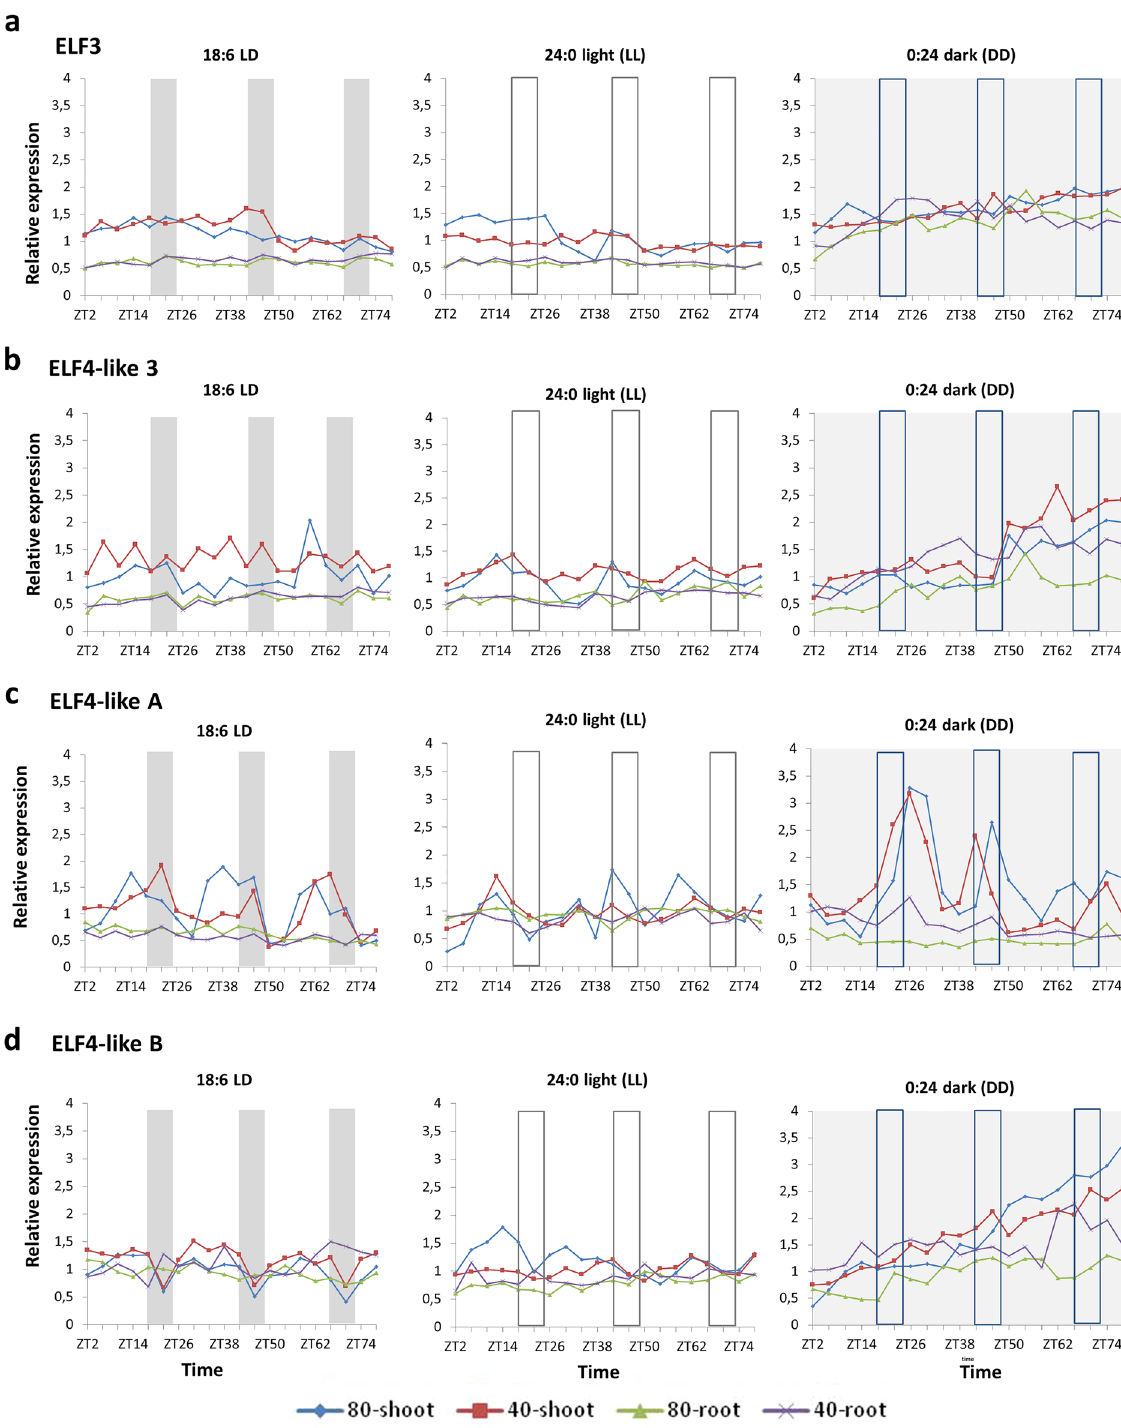
Figure 3. Time scale expression of Brachypodium distachyon ELF -related genes. Gene expression of BdELF3 ( a ) and BdELF4-like genes [ ELF4-like 3 ( b ), ELF4-like A ( c ) and ELF4-like B ( d )] were monitored by qRT-PCR over 76 h in total aerial parts (shoot) and total roots (root) of Brachypodium distachyon under two watering conditions [80% soil water content (80) and 40% soil water content (40)] and three lighting regimes (18:6 light:dark, 24:0 light and 0:24 dark). Plants were entrained for 4 weeks in 18:6 light:dark cycles (light period: 6:00 to 24:00; dark period: 24:00 to 6:00) before being exposed to the three different lighting regimes. As regards water status, plants were grown under 80% soil water content for 2 weeks before being subjected to modest water deprivation (40% soil water content) for 2 weeks before sampling. Bars represent the periods of night (grey bars) and subjective night (empty bars). Expression levels shown are relative to the average expression of two reference genes ( BdUBC18 and BdElFα ) and relative to the mean expression level of the target gene over the 76 h in shoot grown under 18:6 light:dark cycles and 80% soil water content. Data shown are from two representative experiments. Related period, phase, amplitude and relative amplitude error dataset can be found in Supplementary Table S3. Standard deviation and related expression dataset from the two experiments are shown in Supplementary File